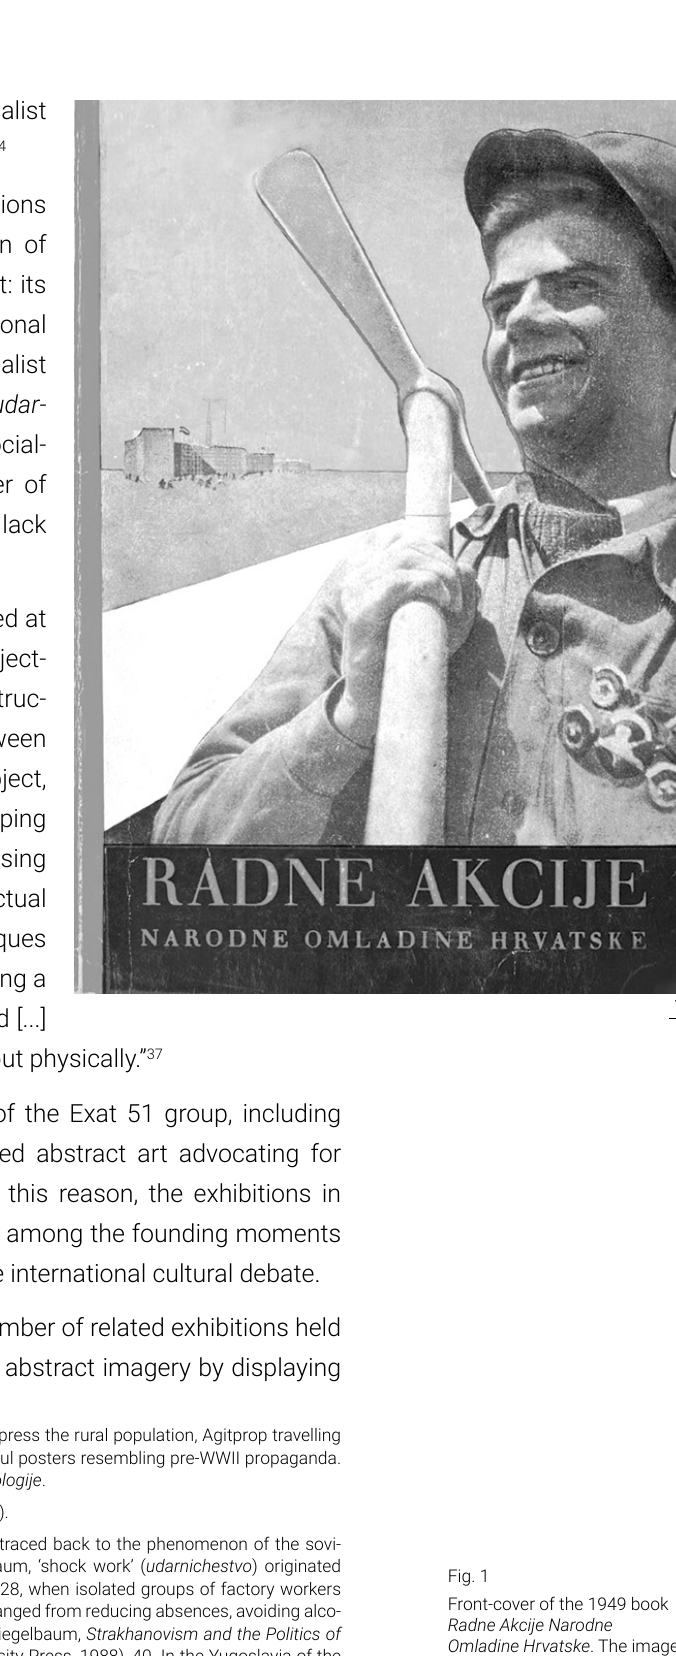
Fig. 1 Front-cover of the 1949 book Radne Akcije Narodne Omladine Hrvatske . The image is a collage by the famous art- ist Ivan Picelj representing an udarnik , a young